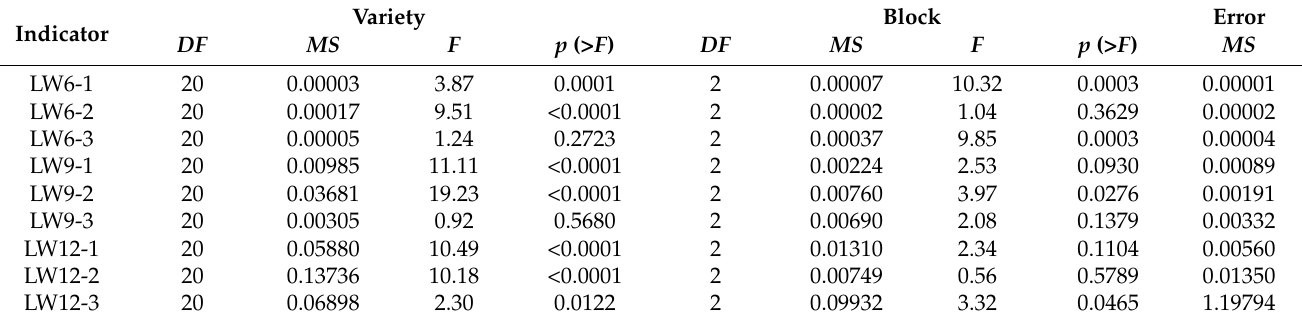
Table 3. The ANOVA of larval weight of common cutworm feeding on four sensitive and seventeen resistant yardlong bean varieties in three verification